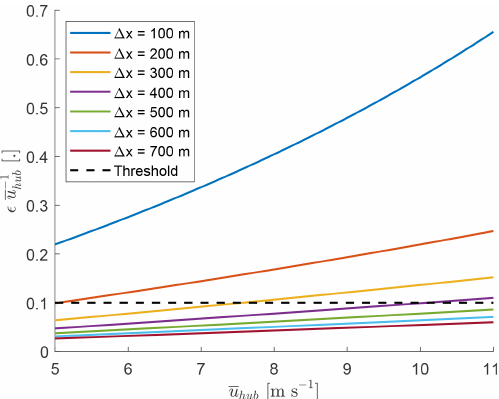
Figure 3. Error of the estimated downstream advection velocity of wake meandering ( (cid:15) ) as a function of the mean wind speed at hub height ( u hub ) and the spatial separation ( (cid:49)x ). If the error becomes larger than the threshold, the detected advection velocity is